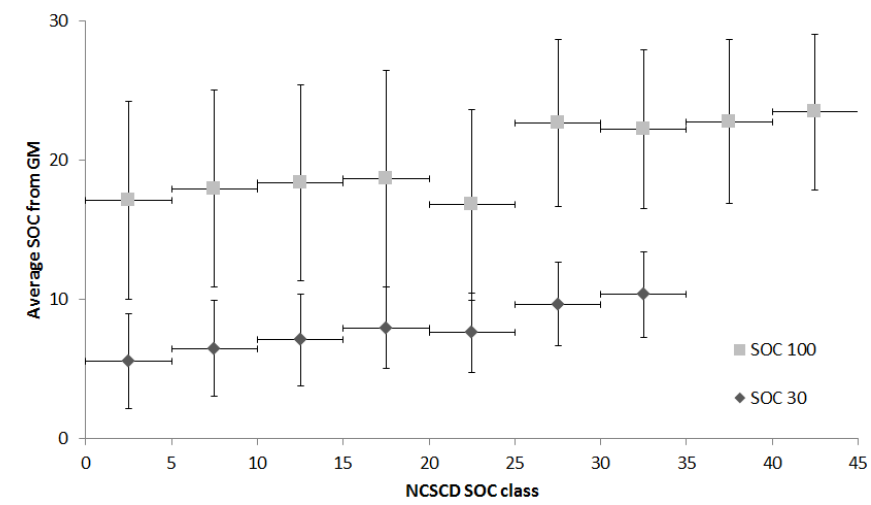
Figure 7. SOC in kgm − 2 from the GM results averaged over a class range of 5kgm − 2 in the